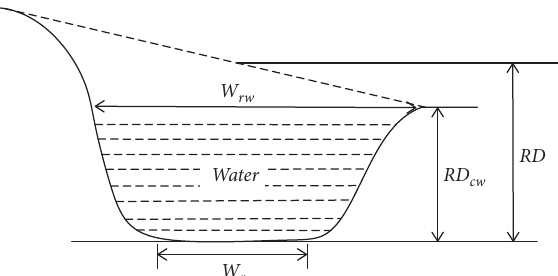
Figure 1: Illustration of a rutting covered with